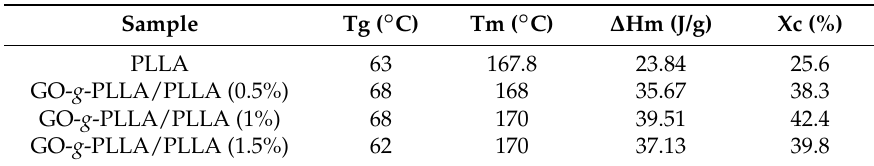
Table 1. The glass transition temperature (Tg), melting temperature (Tm), enthalpy of melting ( ∆ Hm), and degree of crystallinity (Xc) of PLLA and GO- g -PLLA/PLLA.